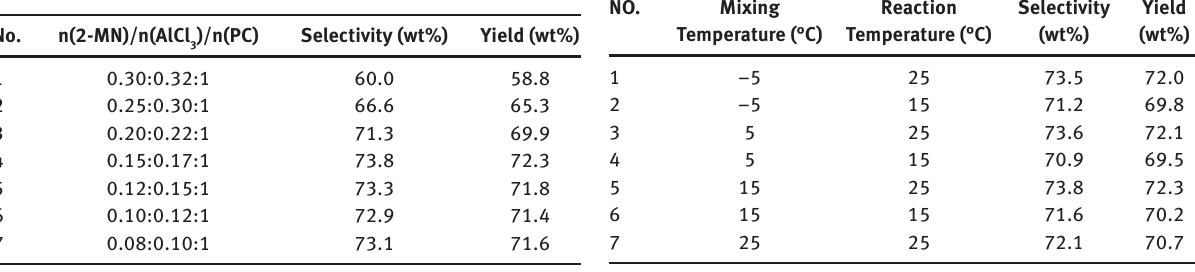
Table 2: The relationship between the molar ratio of the reactants and the results of the acylation reaction of 2-MN.